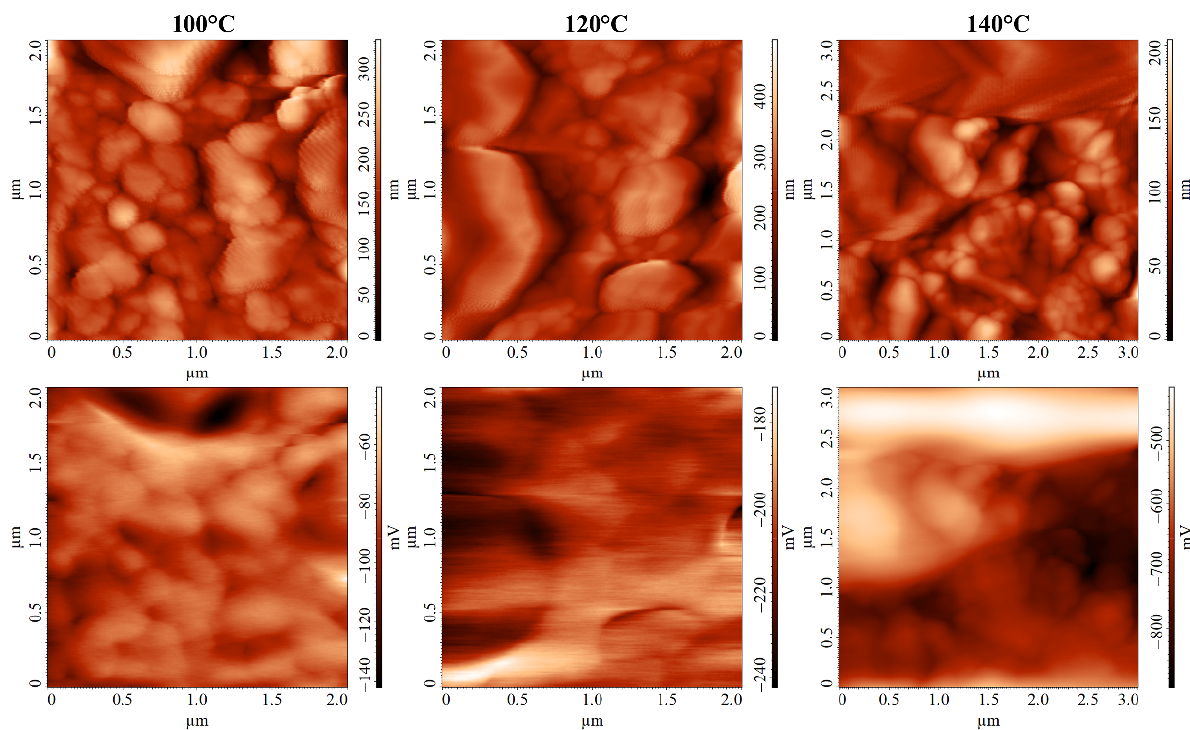
Figure 8. AFM micrographs of the surface of Ag films grown at different temperatures ( top —film surface topography; bottom —the corresponding maps of surface potential distribution).